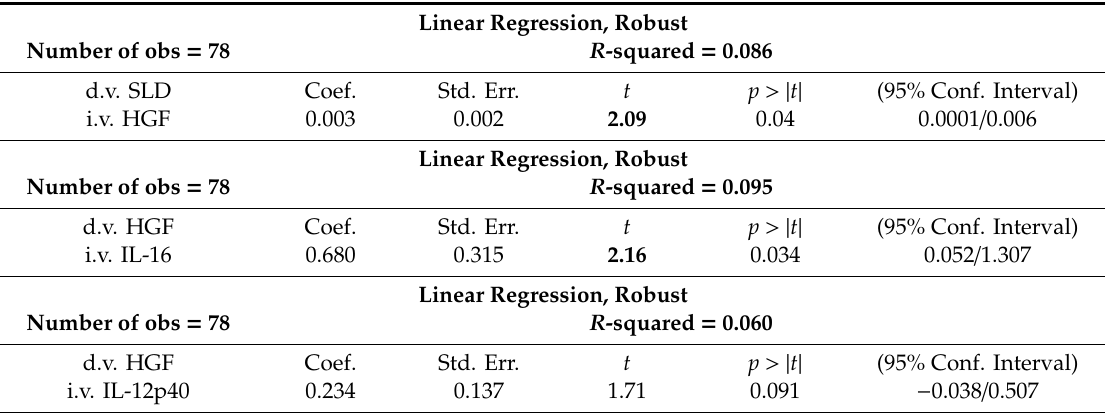
Table 5. Prediction of SLD, IL-16 and IL-12p40 levels by HGF. Linear Regression, Robust